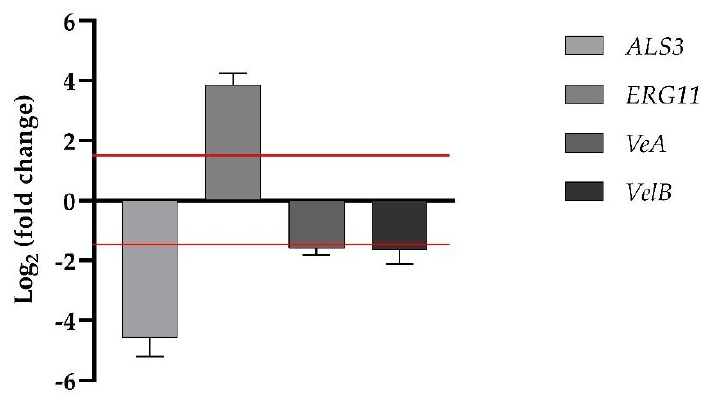
Figure 6. Real-time qPCR after treatment with compounds at synergistic concentrations. Histograms show the differences in the expression levels of four genes; fold differences greater than ±1.5 (see dotted red horizontal guidelines at values of +1.5 and -1.5) were considered significant.